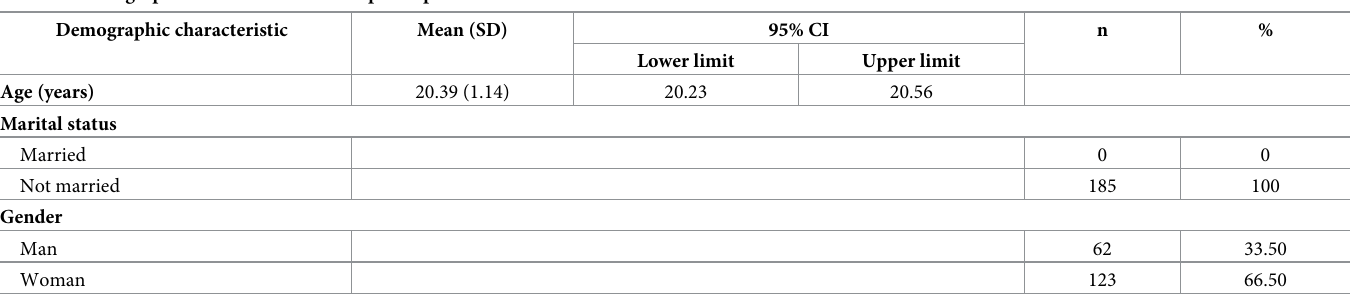
Table 1. Demographic characteristics of the participants.